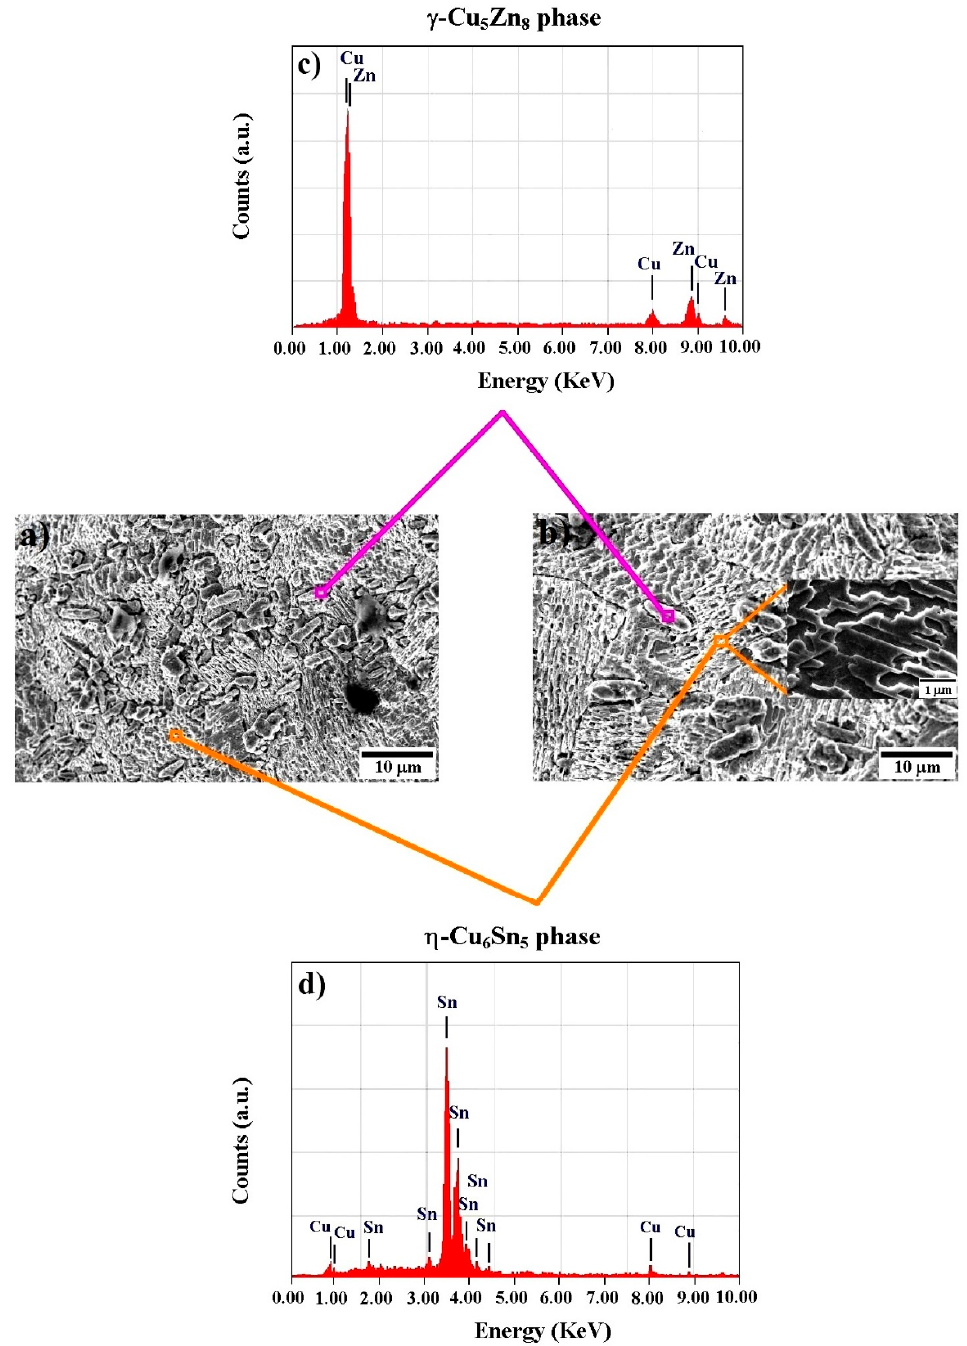
Figure 4. ( a ) SEM image of SZ-1Cu alloy aged at 323 K, ( b ) SEM image of SZ-1Cu alloy aged at 398 K, ( c ) EDS spectrum of γ -Cu 5 Zn 8 phase, and ( d ) EDS spectrum of η -Cu 6 Sn 5 phase.